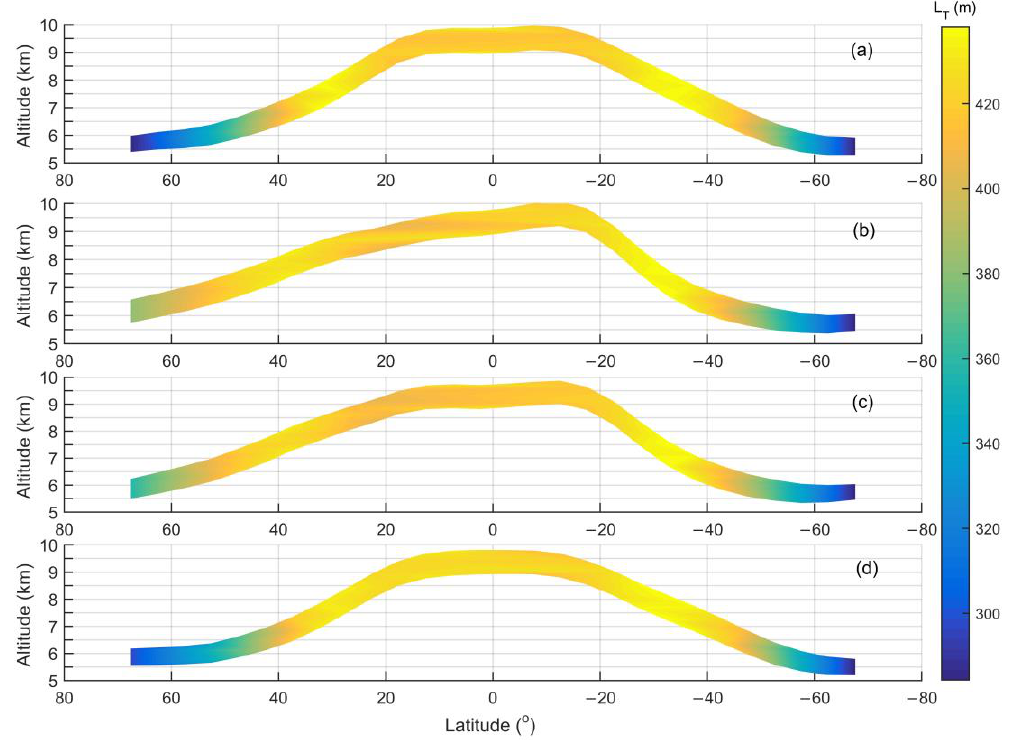
Figure 4. The distribution of SMLT with a latitude after zonal averaging in 2007. ( a ), ( b ), ( c ) and ( d ) represent spring, summer, autumn and winter. The vertical thickness of the line represents thickness of SMLT, and the color of the line represents L T of SMLT. Table 3. Statistical characteristics of SMLT after zonal averaging in 2007.